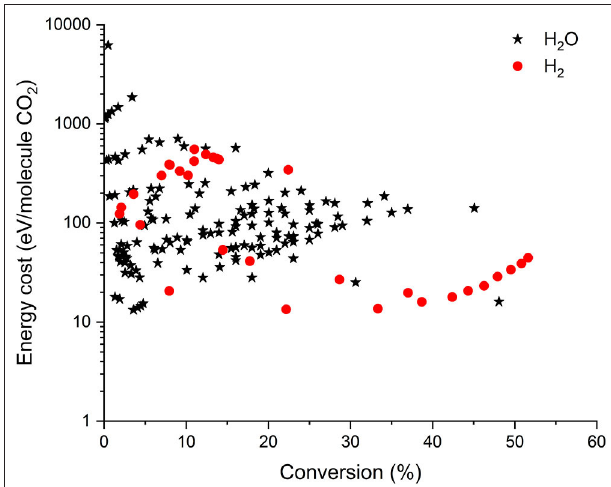
FIGURE 4 | Comparison of all data from literature for the combined CO 2 + H 2 O (*) and the combined CO 2 + H 2 ( • ) conversion in different plasma reactors, illustrating the energy cost per converted CO 2 molecule as a function of conversion. Some data are recalculated from the original references, to account for (among others) dilution